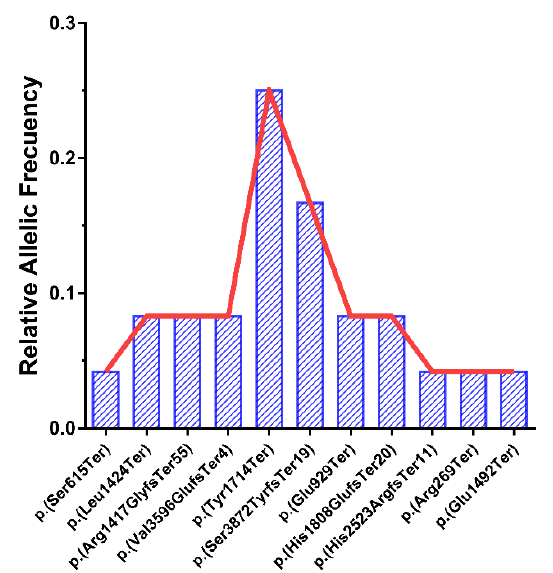
Figure 2. Different relative allele frequencies for the pathogenic variants detected in the cohort, expressed as a fraction of total alleles ( N =